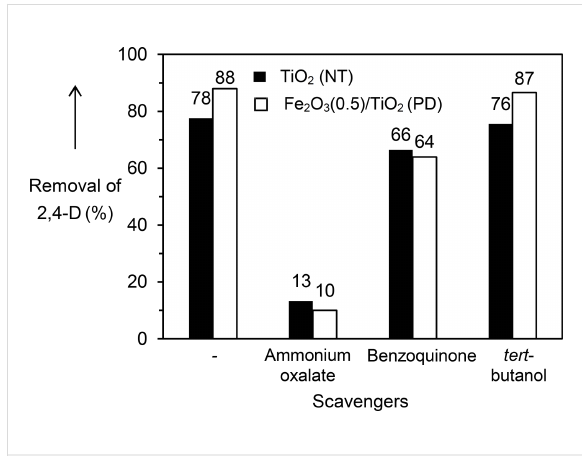
Figure 7: Percentage removal of 2,4-D on unmodified TiO 2 (NT) and Fe 2 O 3 (0.5)/TiO 2 (PD) in the absence and presence of various scav- engers under UV light irradiation for 1